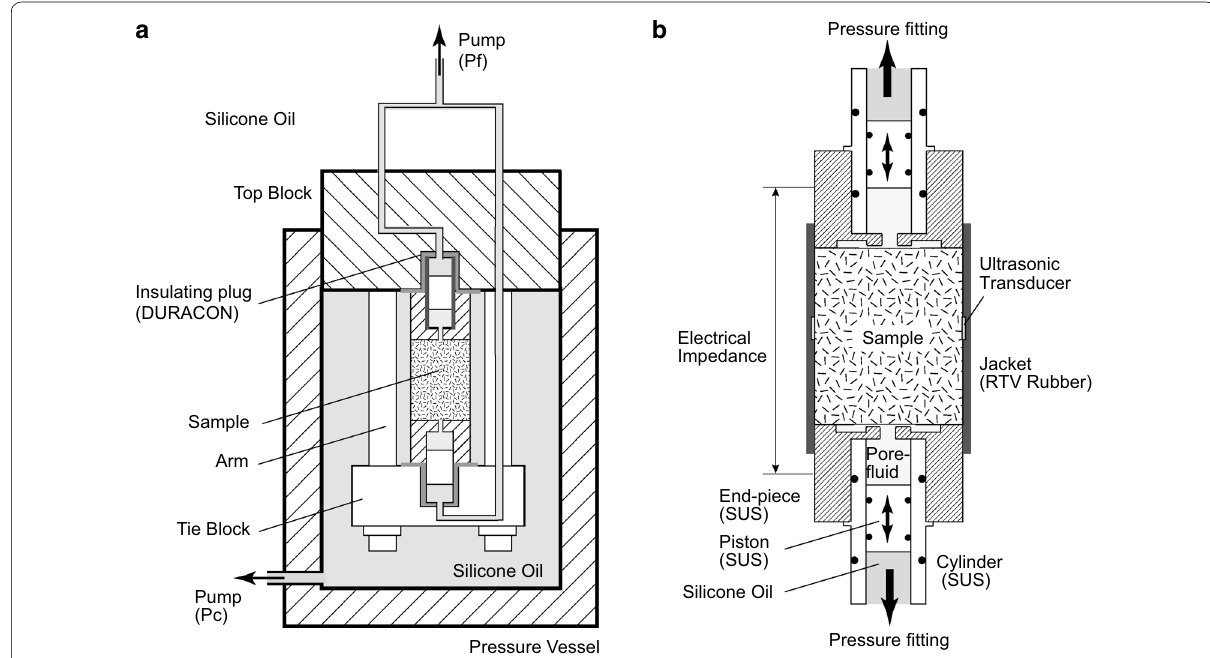
Fig. 2 Illustrations of a pressure vessel and b sample